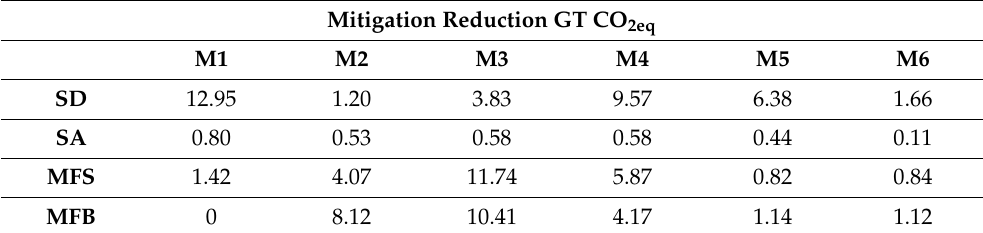
Table 5. Emission mitigation potential for 2022–2100 by different